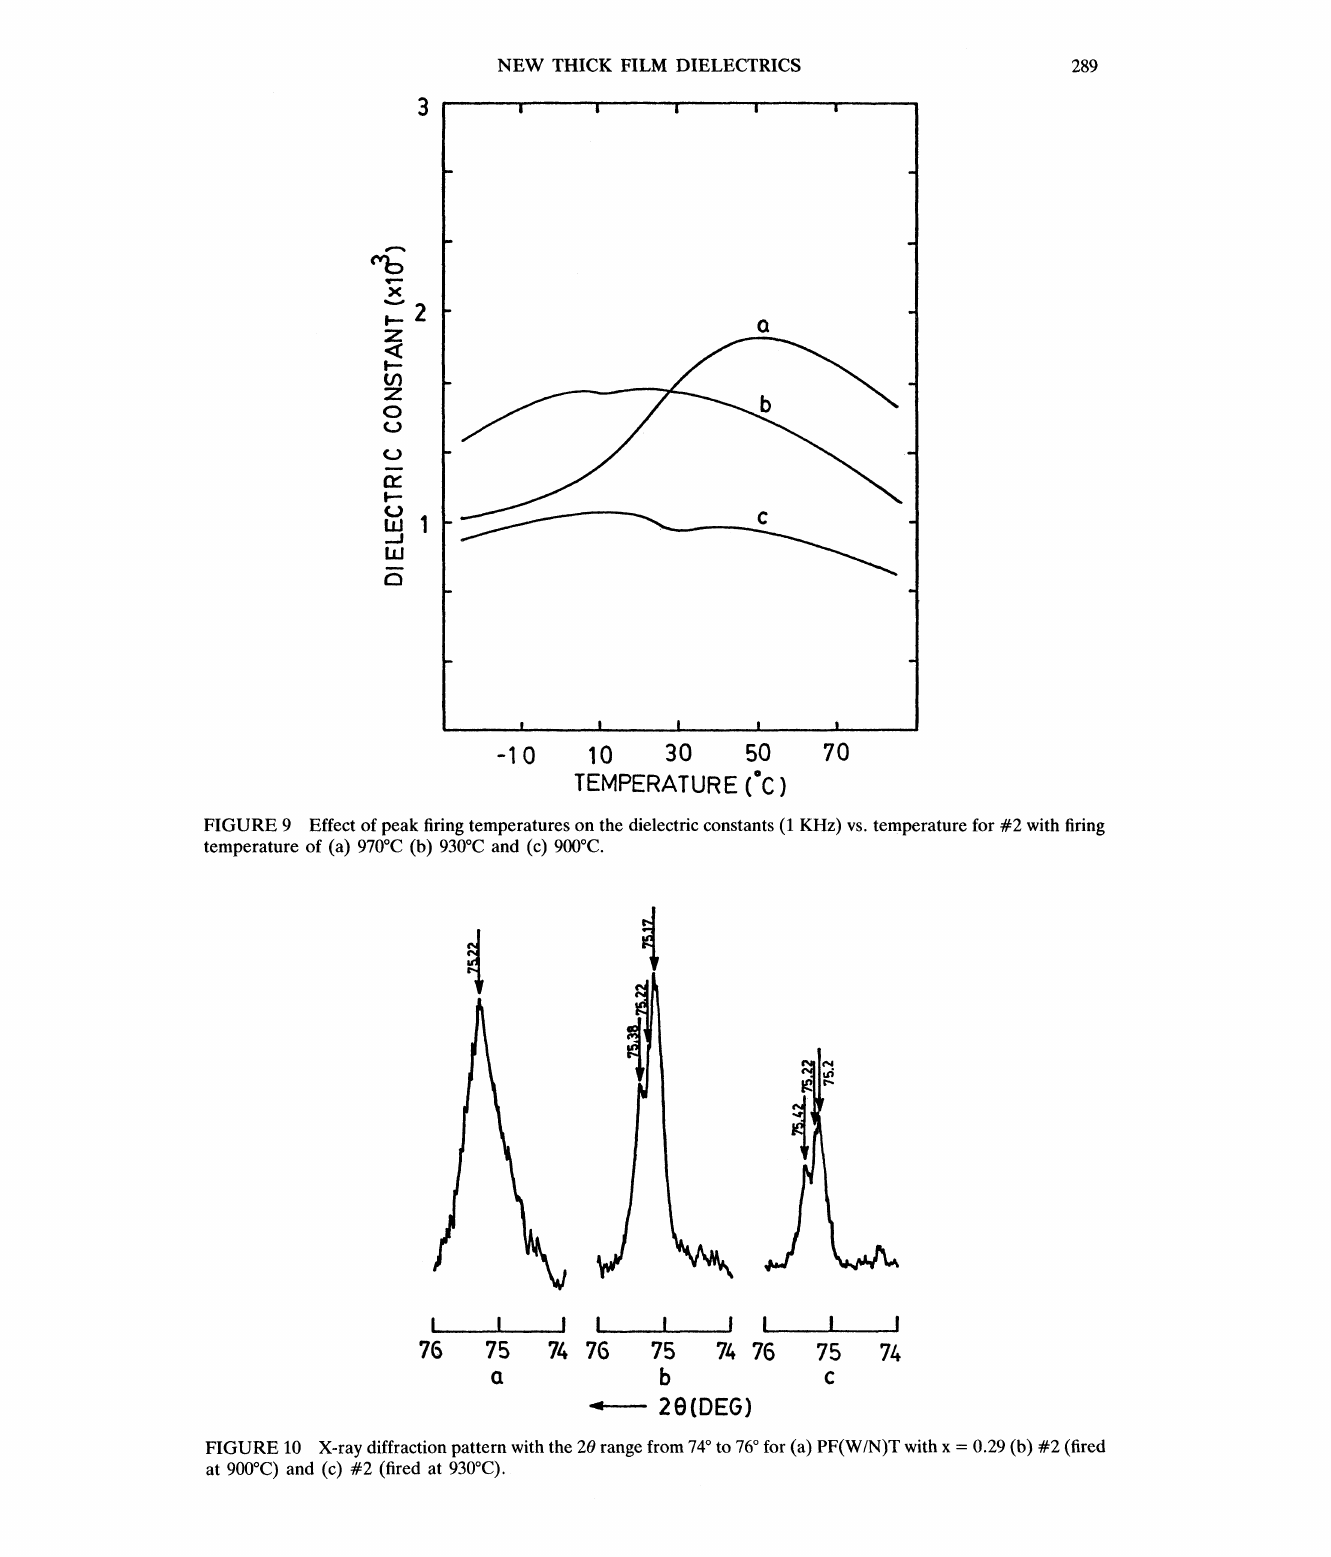
FIGURE 10 X-ray diffraction pattern with the 20 range from 74 to 76 for (a) PF(W/N)T with x 0.29 (b) #2 (fired at 900C) and (c) #2 (fired at